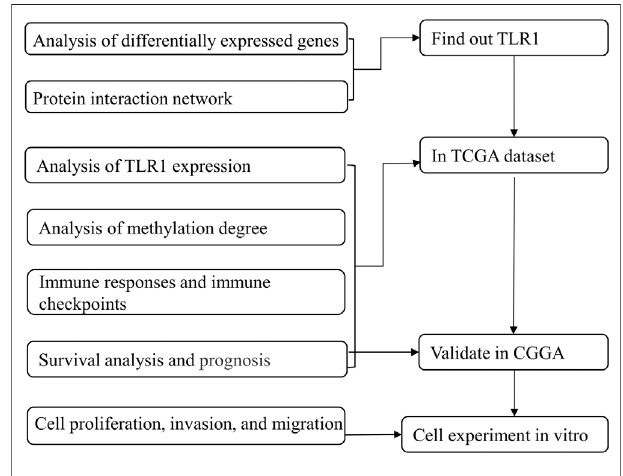
FIGURE 1 | Flow progress